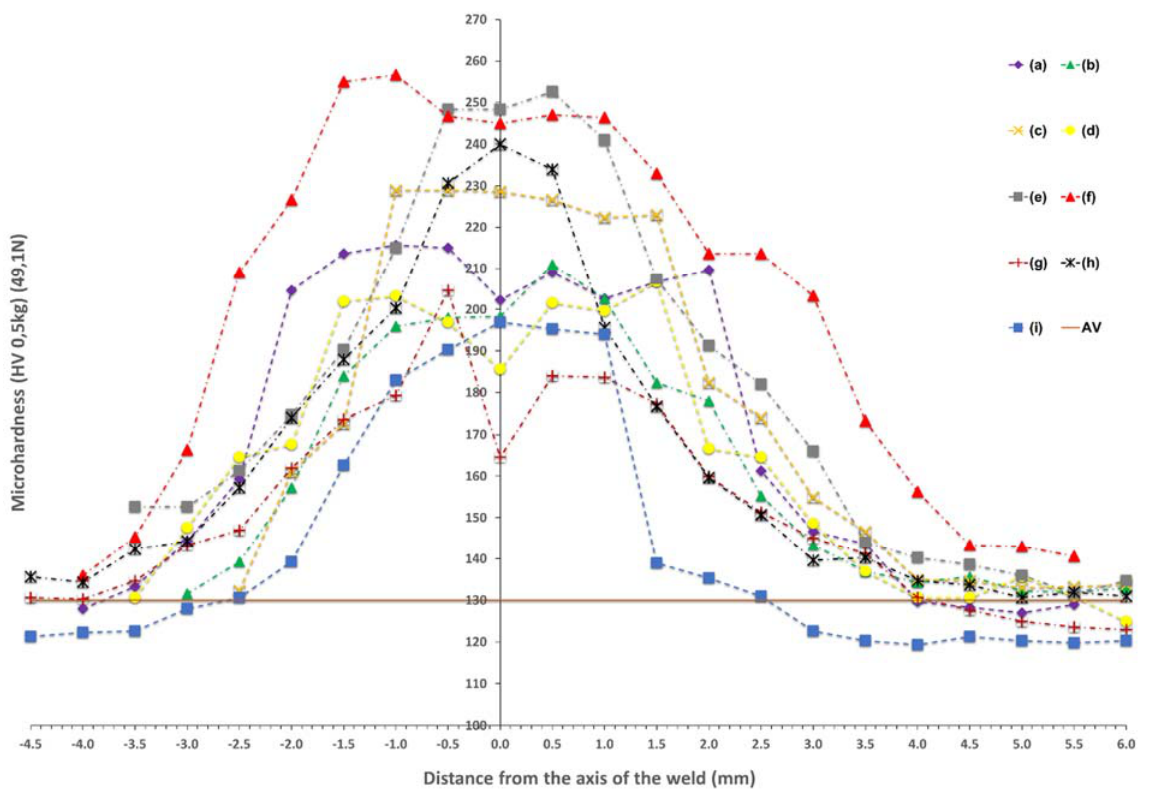
Figure 7. Distribution of the microhardness of the joints depending on the bonding process used: ( a ) manual MAG135, ( b ) manual MAG138, ( c ) robotic MAG135, ( d ) robotic MAG138, ( e ) CMT solid wire, ( f ) CMT flux-cored wire, ( g ) butt welding, ( h ) robotic laser, ( i ) manual laser with solid wire, AV - the average value of the microhardness of the base material.